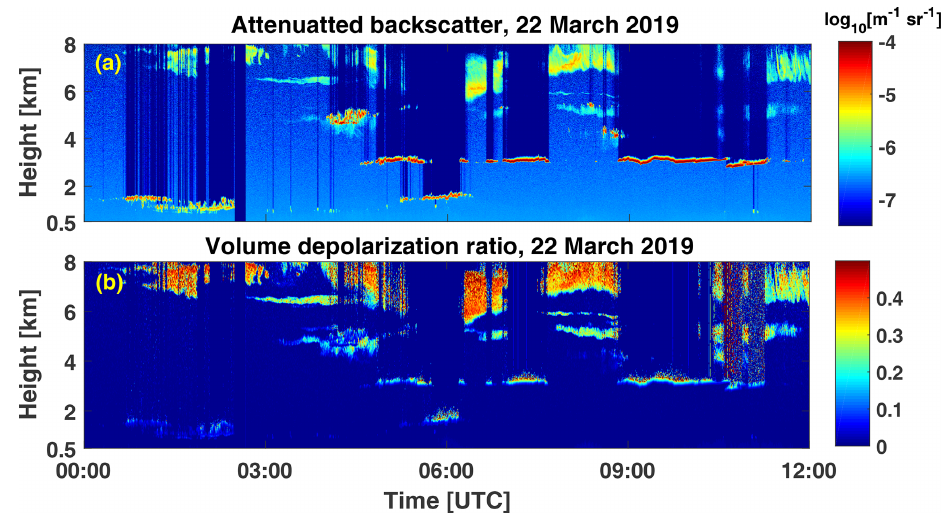
Figure 2. Liquid-water cloud layers at heights < 3.5km and ice-containing clouds between 4 and 8km height in the pristine marine atmo- sphere over Punta Arenas observed with polarization lidar on 22 March 2019. Height–time display of (a) attenuated backscatter at 1064nm and (b) volume linear depolarization ratio at 532nm measured with 30s temporal and 7.5m vertical resolution are presented.